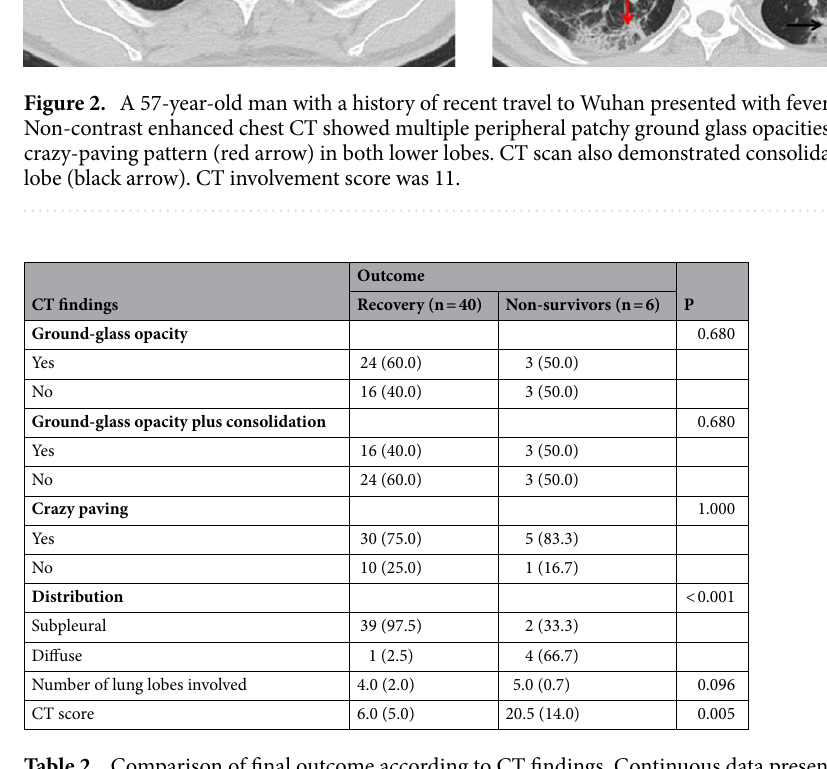
Table 2. Comparison of final outcome according to CT findings. Continuous data presented as median (IQR), categorical data as n (%), CT computed tomography.